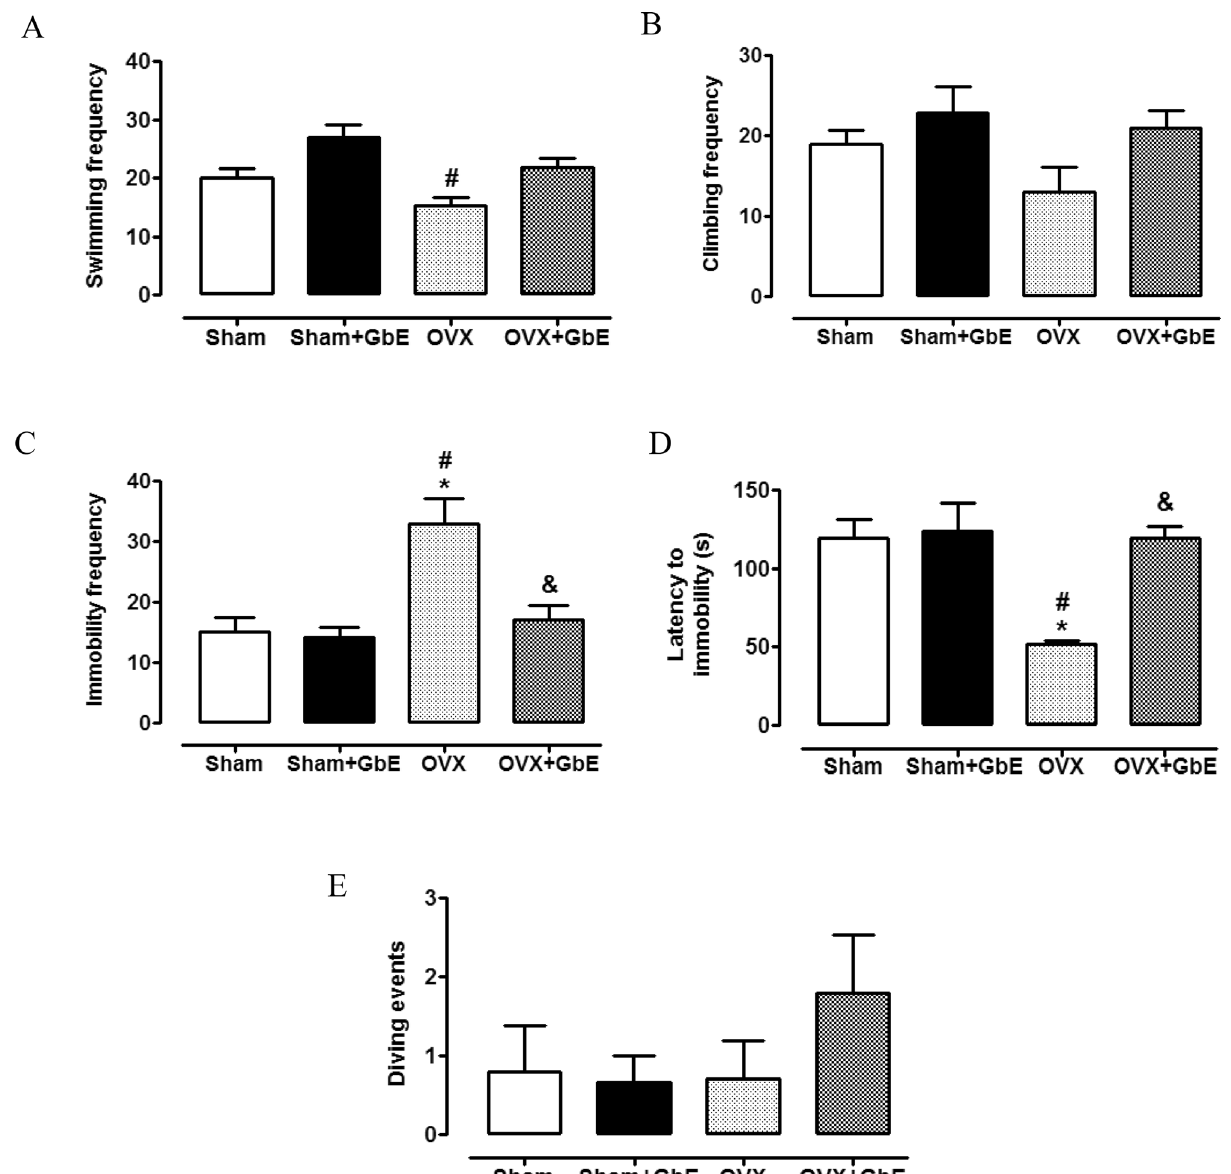
Figure 3. Depressive-like behaviours during the Modified Forced Swim Test. ( A ) Swimming, ( B ) climbing, ( C ) immobility frequencies, ( D ) latency to immobility and E) diving events of Sham (n = 8–9), Sham + GbE (n = 10–11), OVX (n = 9–10) and OVX + GbE rats (n = 9–10). *p ≤ 0.05 vs. Sham; # p ≤ 0.05 vs. Sham + GbE; & p ≤ 0.05 vs.